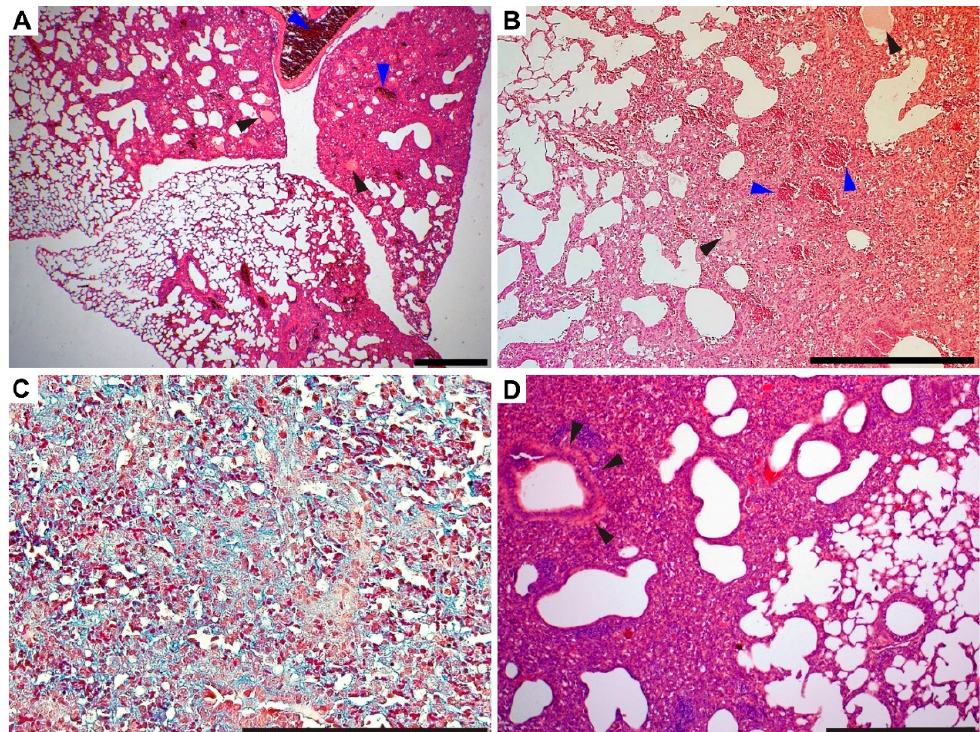
Figure 6. Heterogeneity of L. pneumophila Sg 1, ST 62, Mab Knoxville acute infection. Histopatholog- ical lung sections demonstrate multiple pathological changes, such as hyperemia ( A , blue arrow- heads), alveolar edema ( A , B , black arrowheads), hemorrhage ( B , blue arrowheads), fibrosis ( C , blue staining), and atelectasis with severe diffuse inflammation ( D , black arrowheads). The sections are related to high-dose-challenged mice euthanized at 5 dpi ( A , B ) and 10 dpi ( C , D ). H&E ( A , B , D ) and Masson’s trichrome ( C ) are shown; scale bars: 500 µ m.